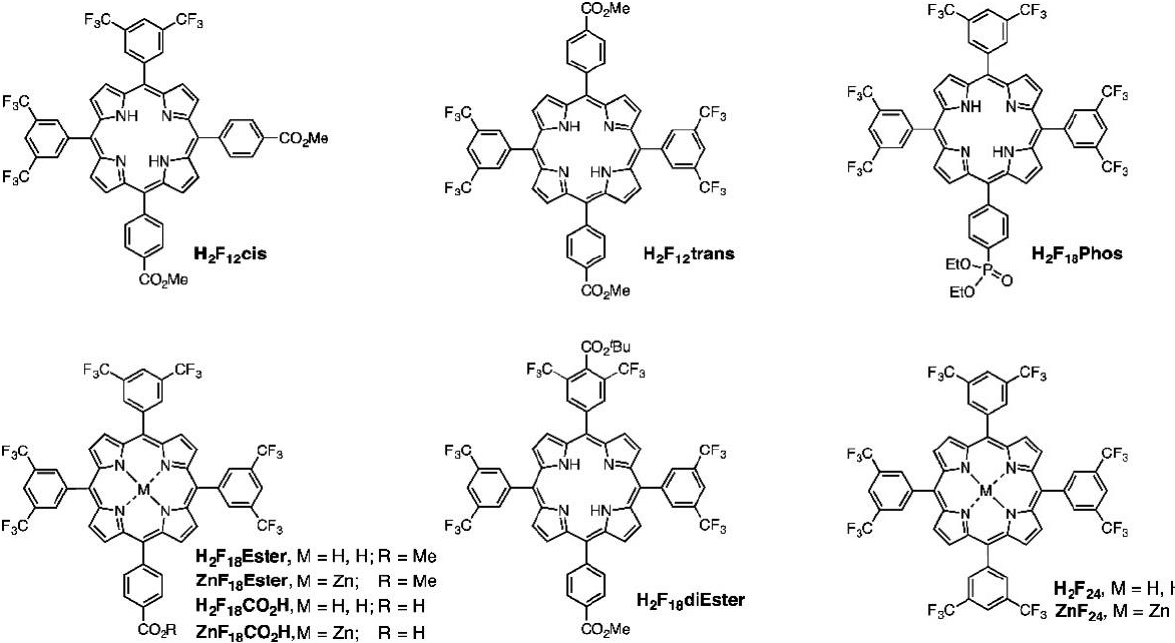
Figure 29. Structures of ten trifluoromethylated porphyrins. Reproduced from reference [106] with permission from the American Chemical Society, copyright 2016.